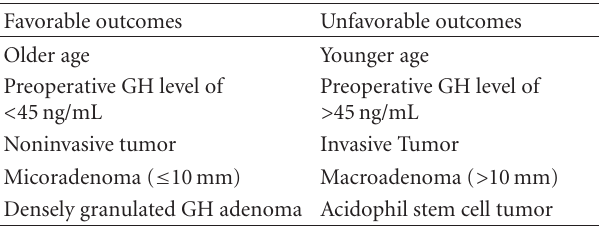
Table 1: Preoperative factors correlating with surgical outcomes in acromegaly [7,